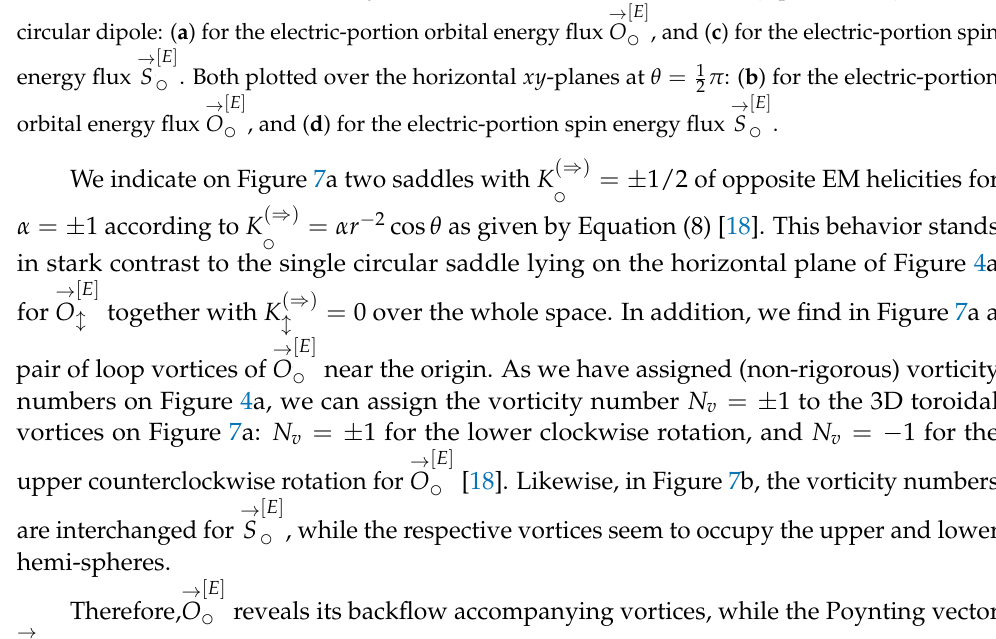
cone of higher values of DoCP.